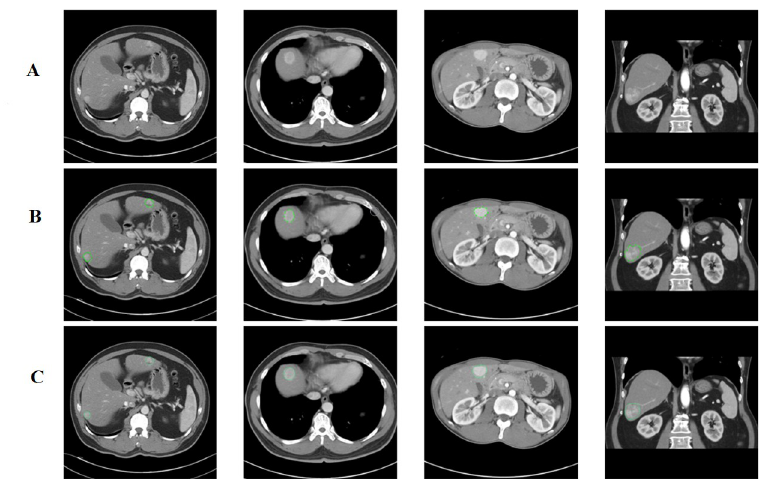
Fig 2. (A) Abnormal Hyperdensities Without Labeling ROI. (B) Hyperdensities with hand-marked ROIs. (C) Hyperdensities with AI-predicted ROIs.